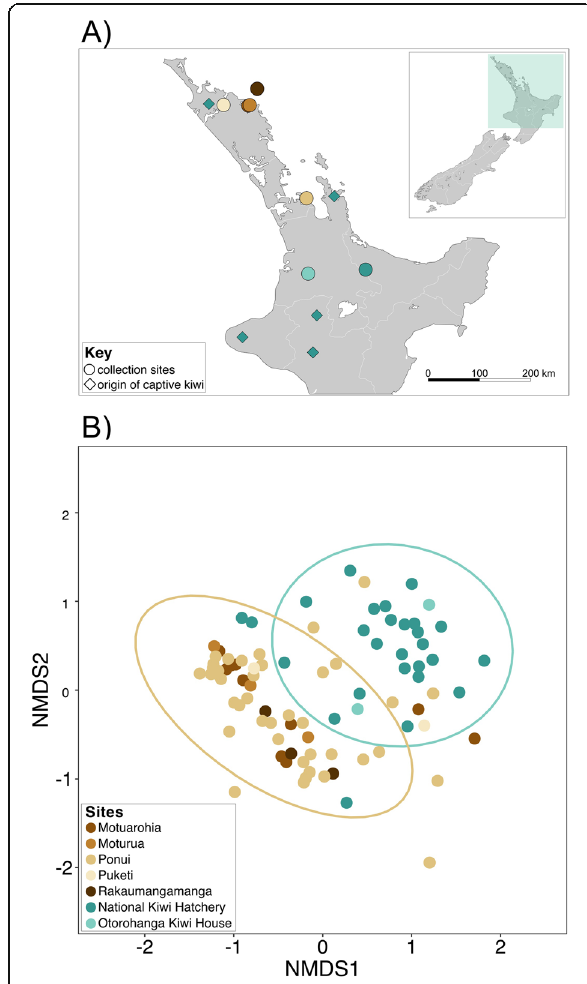
Fig. 1 Captivity but not geography shifts the Brown Kiwi gut bacterial composition. A Map of collection sites and captive kiwi origin sites where shapes indicate type of site. Collection sites are locations where kiwi feces were sampled and origin sites are where kiwi eggs were lifted. Colors correspond to key in panel b . Teal colors correspond to captive sites, while brown colors correspond to wild sites. B NMDS plot using Bray-Curtis distance metric shows samples clustering by captivity status with little overlap between the groups (PERMANOVA, r 2 = 0.07, p = 0.001). Ellipses denote 95 % confidence